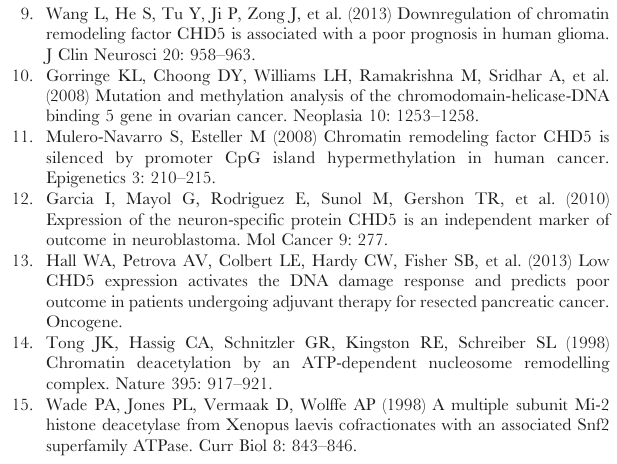
Figure S1 Mass spectrometry results of the factors present in the CHD5-containing complex that was purified by tandem affinity purification from HeLa cells. The number of unique peptides for each factor is listed. (TIF) Figure S2 Top hits from the microarray analysis of KELLY cells transiently transfected with vector or a CHD5 cDNA. The fold change represents the signal from the CHD5 transfected cells divided by the signal from the cells transfected with the vector. CHD5 and WEE1 (highlighted in gray) were validated by qRT-PCR. The raw data are accessible at NCBI [GEO Accession: GSE59899]. (TIF) Figure S3 (A) Transient expression of CHD5 at low levels in Kelly cells does not significantly affect CHD4 protein or transcript levels. (B) siRNA-mediated knockdown of CHD5 in PANC-1 cells does not affect CHD4 protein levels. The replication protein A subunit, RPA2 was used as a control. (TIF) Figure S4 Combining transient expression of CHD5 in KELLY cells with a WEE1 inhibitor reduces cell growth. KELLY cells were transiently transfected with vector or the CHD5 cDNA and incubated with a WEE1 inhibitor. The relative cell count was determined by measuring the cell viability at the indicated days divided by the starting cell viability at day 0. Data are represent mean and SD [n = 3]. (TIF) Table S1 Sequences of the primers used in the ChIP